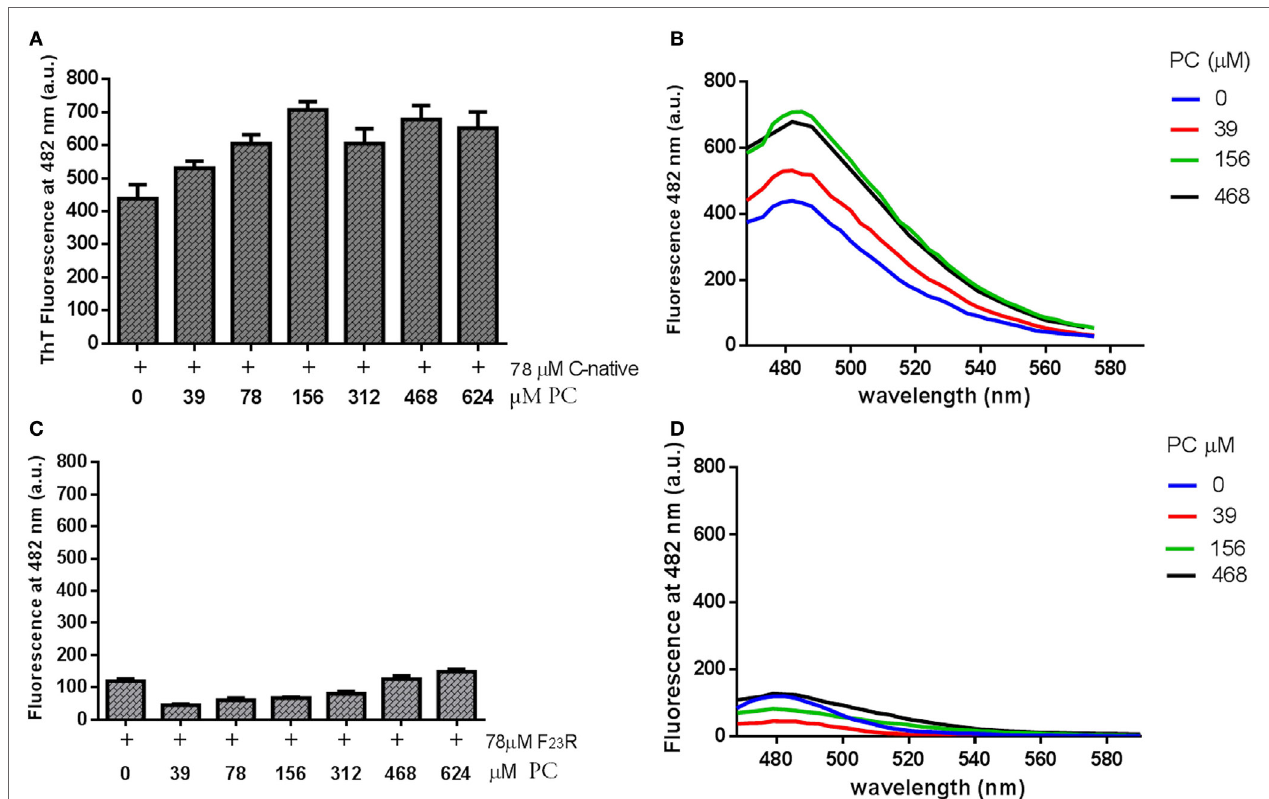
FigUre 4 | Effect of phosphatidylcholine (PC) vesicles on secondary structural changes in peptides derived from islet amyloid polypeptide. (a) Fluorescence values at 482 nm in the native C-terminal incubated with PC vesicles. (B) Under the same conditions, the emission spectra were shown. (c) Fluorescence values in the F 23 R variant incubated with increasing concentrations of PC. (D) Under the same conditions, the emission spectra were